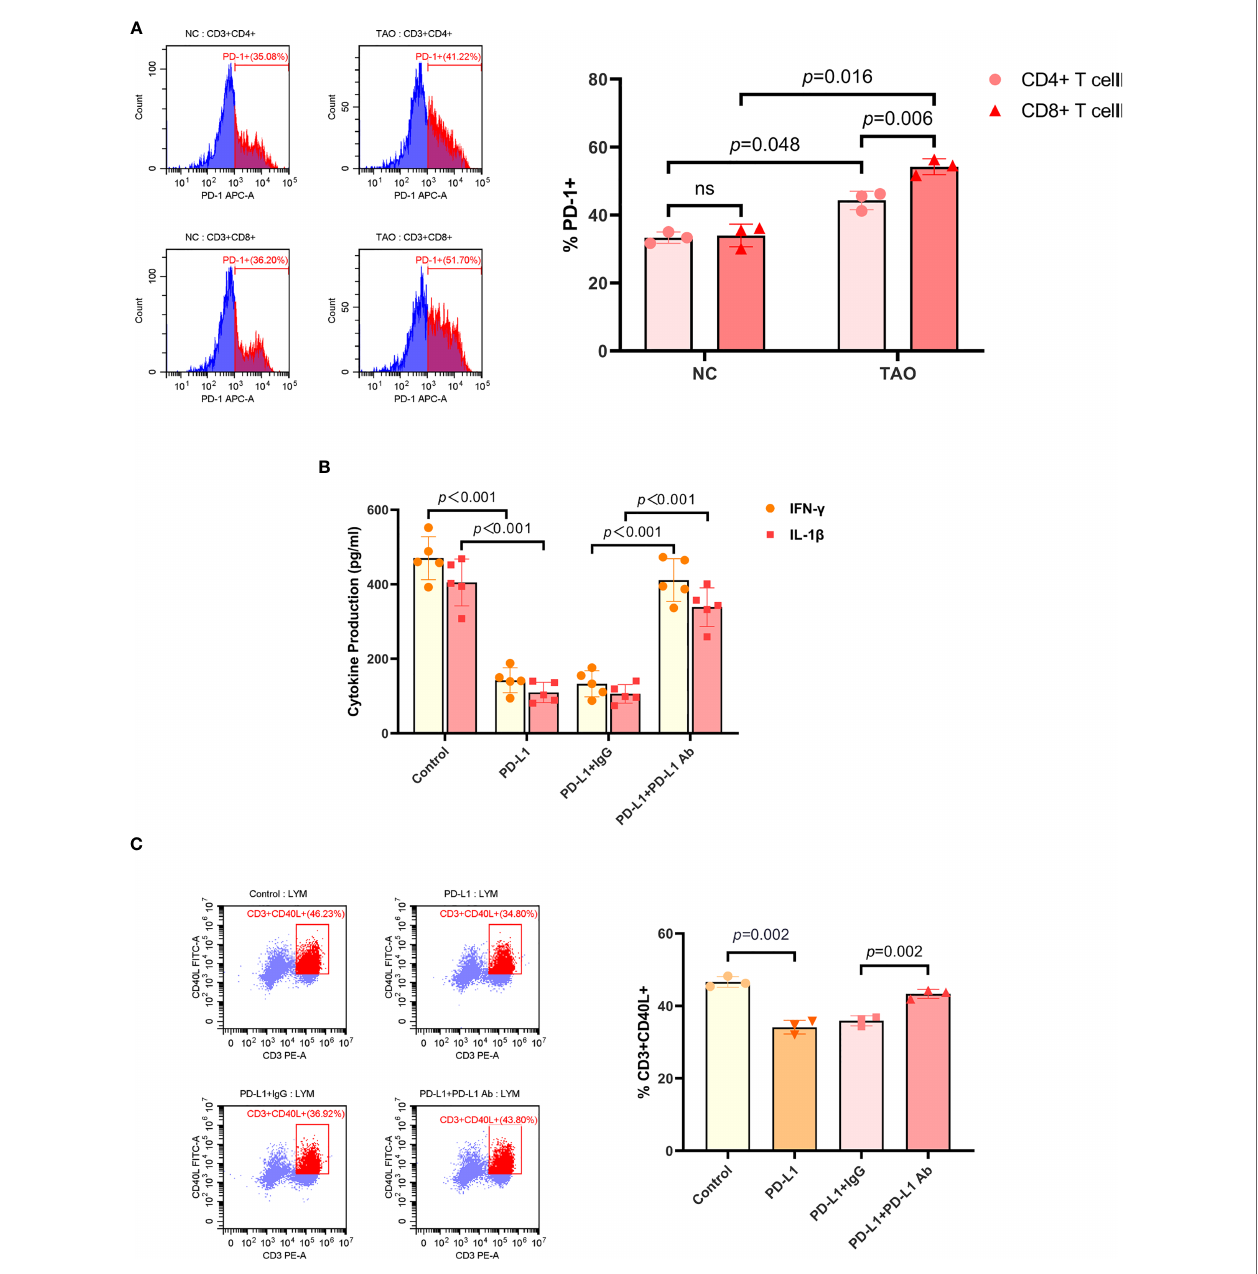
FIGURE 1 | PD-L1 inhibited the activity of T cell. (A) Lymphocytes isolated from peripheral venous blood of TAO patients compared to negative controls were subjected to FCM to detect the proportion of PD-1+ cells in CD4+ T cells and CD8+ T cells. (B) T cells were treated with PBS, recombinant human PD-L1 protein (10 ug/mL), PD-L1 combined with goat anti-human IgG (10 ug/mL), and PD-L1 combined with PD-L1 neutralizing antibody (10 ug/mL), respectively. And the supernatants were subjected to ELISA after a 72-hour culture to detect the secretion of IFN- g and IL-1 b . (C) Lymphocytes isolated from peripheral venous blood of TAO patients were treated with PBS, recombinant human PD-L1 protein (10 ug/mL), PD-L1 combined with goat anti-human IgG (10 ug/mL), and PD-L1 combined with PD-L1 neutralizing antibody (10 ug/mL) for 48 hours, respectively. And the proportion of CD3+CD40L+ cells were determined by FCM. Data are expressed as mean ± SD of three or more repetitions. ns, no signi fi cance. Representative of three or more independent experiments using cells from a different